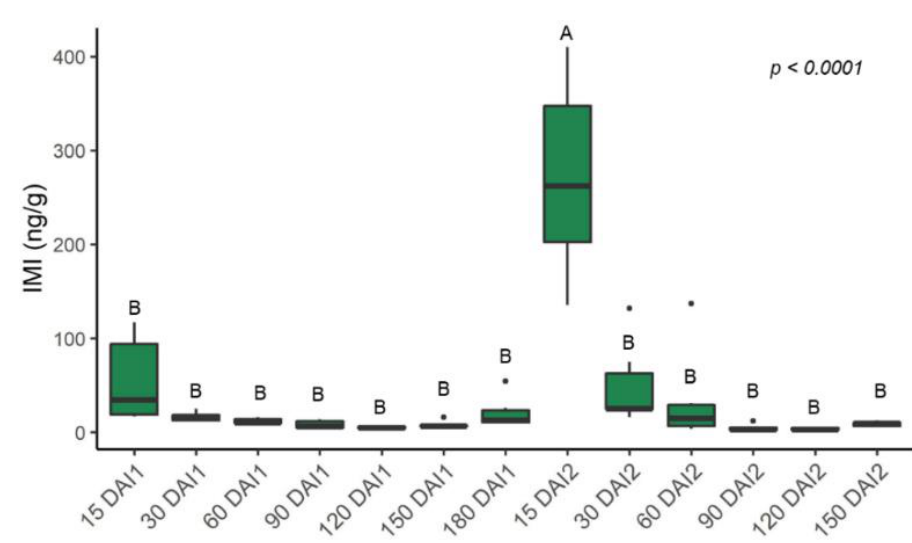
Figure 10. Leaf imidacloprid (IMI) concentrations after injection 1 in October 2020 and injection 2 in April 2021. DAI1 = days after injection 1; DAI2 = days after injection 2. 180 DAI = 0 DAI2. Different letters indicate significant differences ( p < 0.05) between time points according to Tukey’s honest significant difference test.